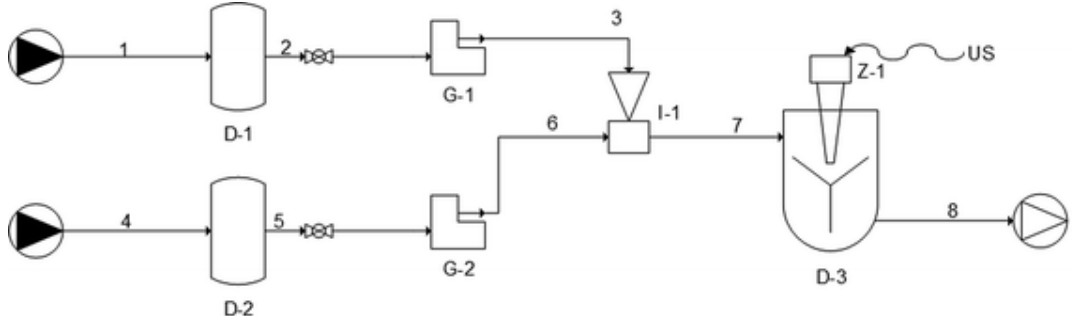
Figure 1. Piping representation for the experimental setup for the simil-microfluidic method: (1–2–3) lipids/ethanol feed line; (4–5–6) water feed line; (D-1 and D-2) feed tanks; (G-1 and G-2) peristaltic pumps; (I-1) injector (production section); (7–8) water/ethanol nanoliposomes suspension; (D-3) recovering/homogenizing tank (from [38], published by The Royal Society of Chemistry).